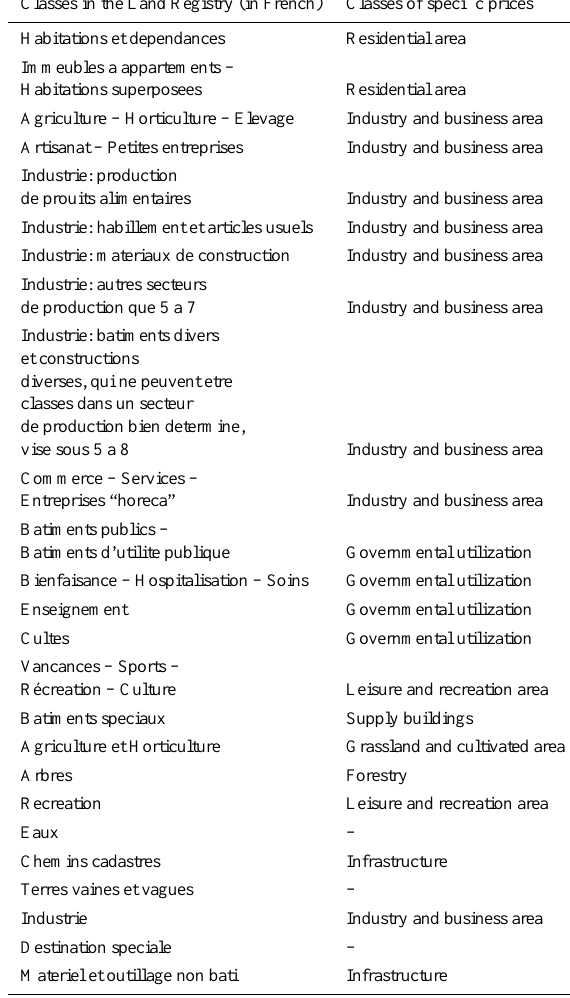
Table A1. Correspondence between the land use categories of the land registry of the Walloon region and the classes of specific price used in the damage